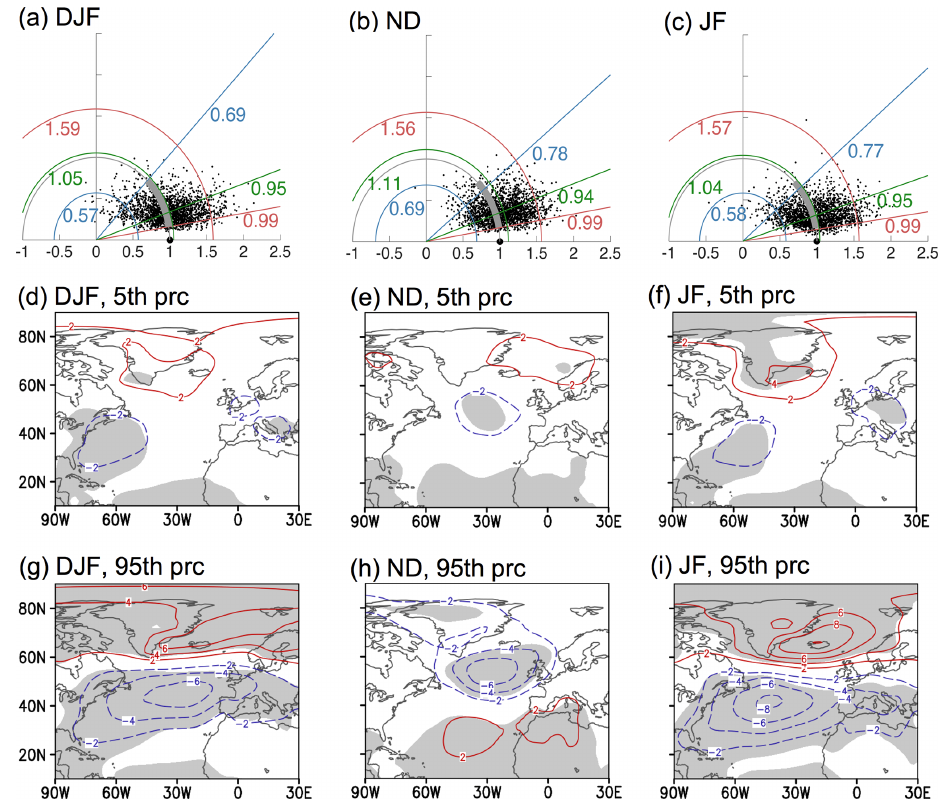
Figure 2. Uncertainty of ENSO (El Niño minus La Niña) teleconnection in the North Atlantic during 1920–2014 for the months shown. Top row: Taylor diagrams for the North Atlantic with 2000 bootstrap SLP composites (represented by the small dots). The blue, green, and red semi-circles indicate the 5th, median, and 95th percentiles of the amplitude ratios. Blue, green, and red lines indicate the 5th, median, and 95th percentiles of the spatial correlation with the observed composite (represented by the large dot). Second and third rows: Bootstrap SLP composites corresponding to the 5th or 95th percentile based on both amplitude ratio and spatial correlation. The contour interval is 2hPa, with red (blue) contours indicating positive (negative) anomalies. Gray shading indicates the 5% significance level for a two-tailed t test. See Sects. 2.4 and 3.1 for more details.